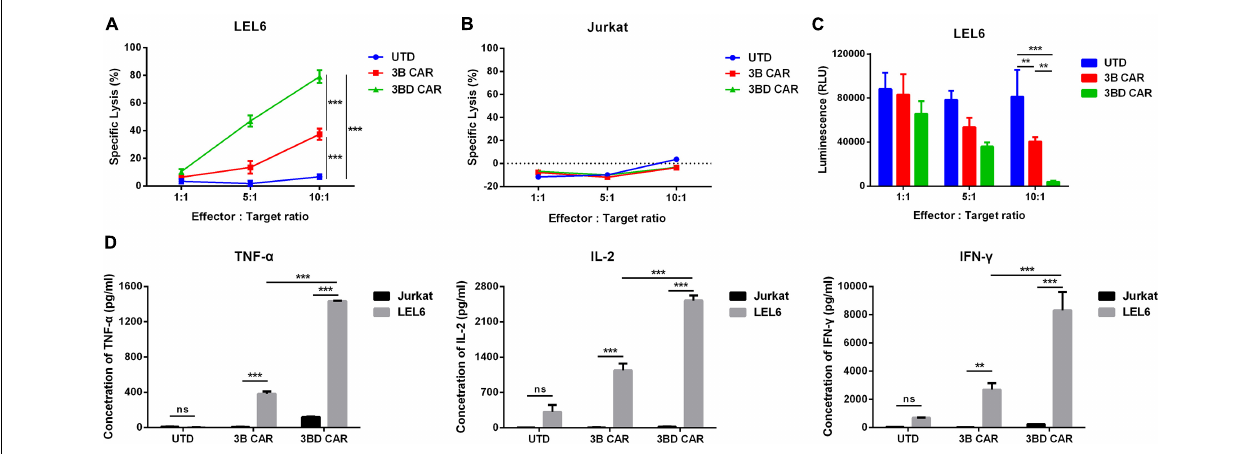
FIGURE 3 | 3BD CAR-T cells showed enhanced cytolytic and cytokine secreted function on LEL6 cells by co-transduction of DNR. Anti-HIV CAR-T cells were incubated with target cells at different ratios (1:1; 5:1; and 10:1) for 8 h. (A) Direct killing of LEL6 was performed using the LDH release assay. (B) Direct cytotoxicity effects on Jurkat cells, as the Env negative control here, were detected. (C) Detection of luminescence (RLU) in co-cultures to reflect lysis of LEL6 cells. (D) TNF- α , IL-2 and IFN-r production in co-cultures. Anti-HIV CAR-T cells were co-cultured with LEL6 cells (1 × 10 4 cells) at 10:1 for 24 h, and supernatants were collected for ELISA. Statistical analyses were performed by two-way ANOVA followed by Bonferroni post-test analysis. ns p > 0.05, ** P < 0.01, *** P < 0.001. Data represent the mean ± SEM of independent